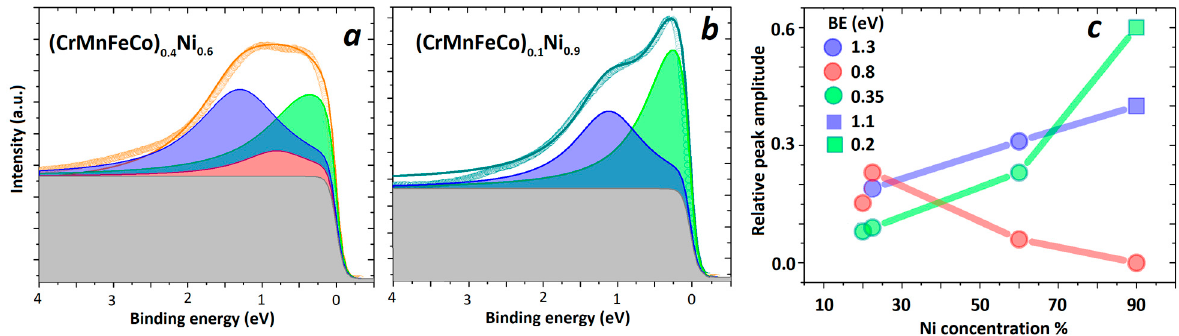
Figure 7. UPS of (CrMnFeCo) 1 − x Ni x and corresponding Lorentzian peaks used to deconvolute the spectrum for ( a ) x = 0.6 ( b ) x = 0.9. ( c ) Plot of the relative peak amplitude as a function of Ni concentration with binding energy (BE) of a corresponding peak indicated.